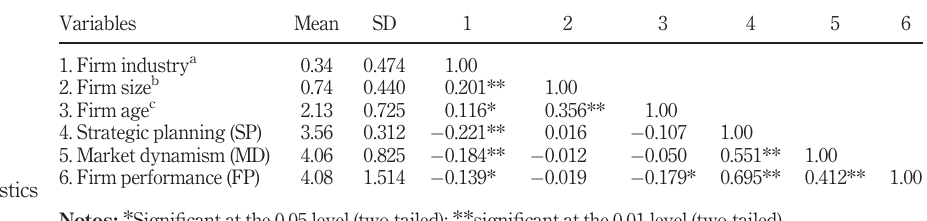
Table III. Descriptive statistics and correlations matrix